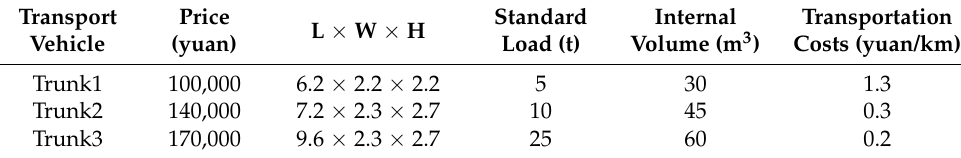
Table 4. Parameters of transport